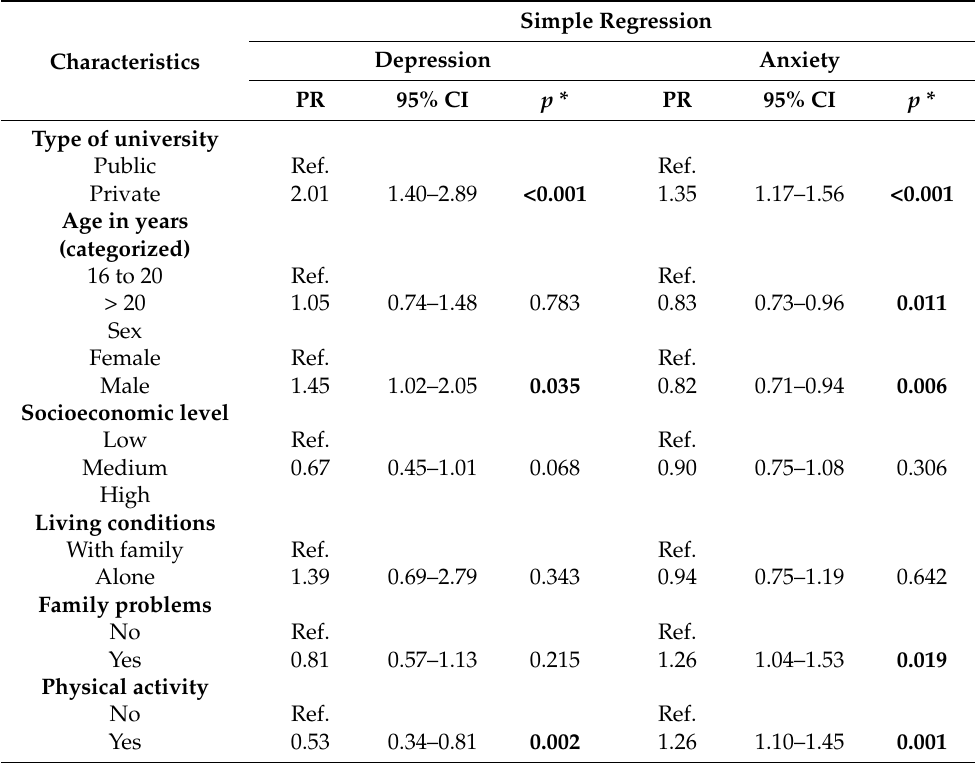
Table 3. Analysis of factors associated with depression and anxiety in medical students in Lam- bayeque,